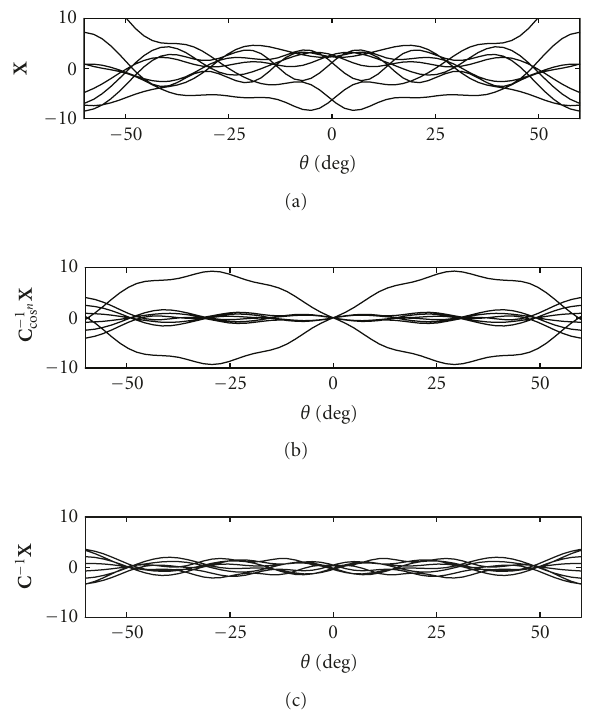
Figure 4: Uncompensated (a) and compensated (b, c) phase dia- grams with E = cos n θ and E = element factor is E true = sin(2 π (3 / 8)cos θ ), which corresponds to h gp = 3 λ/ 8.